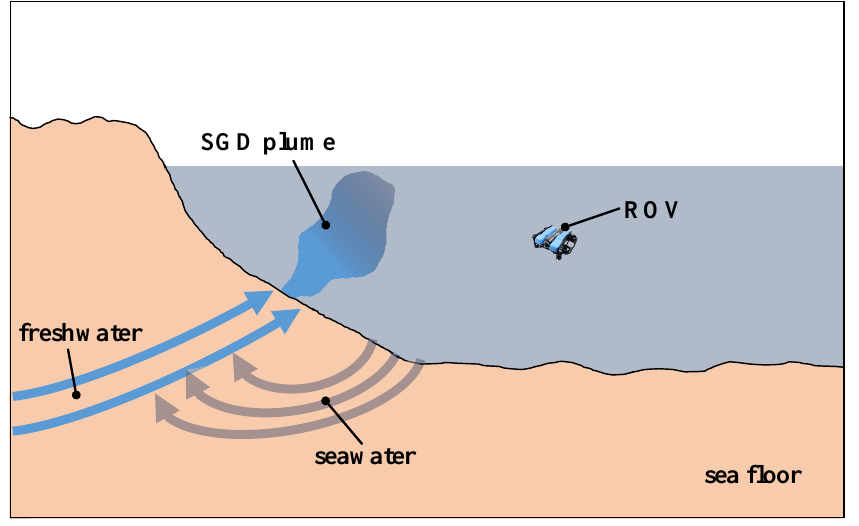
Figure 1. Submarine groundwater discharge (SGD) consists of freshwater and recirculating seawater. SGD plumes can be detected by remotely operated vehicles (ROV), modified after [4].